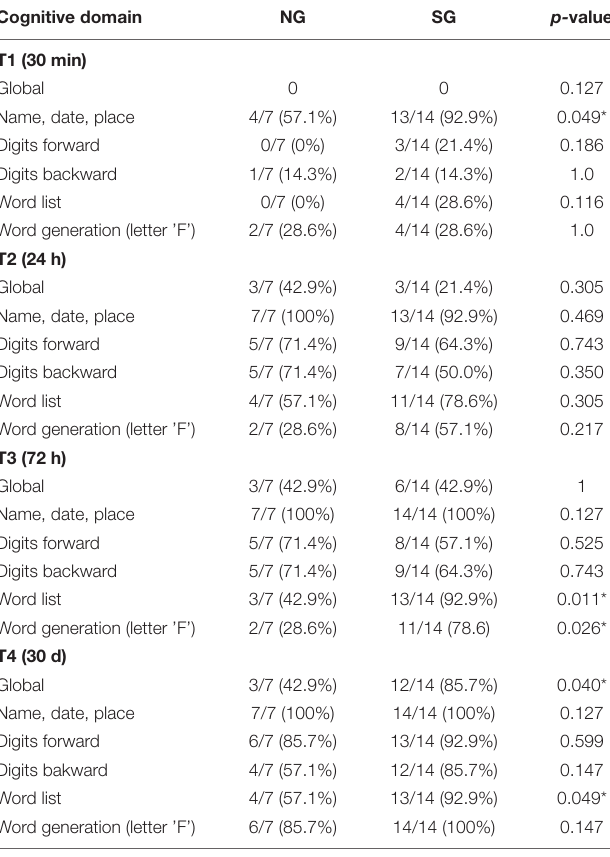
Figure 5 . Behavior Analyses: Spatial Learning Analysis in the Morris Water Maze experimental animals learned to find the platform during the training period (3 days, 3 sessions per day).